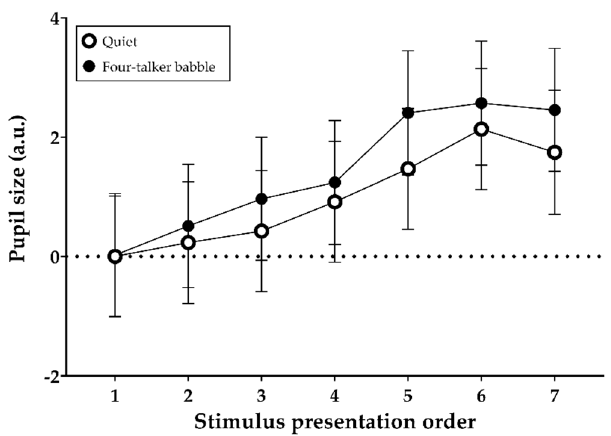
Figure 5. Mean and 95% confidence intervals of sentence-baseline values relative to the initial stimulus baseline in quiet and four-talker babble conditions as a function of stimulus presentation order.